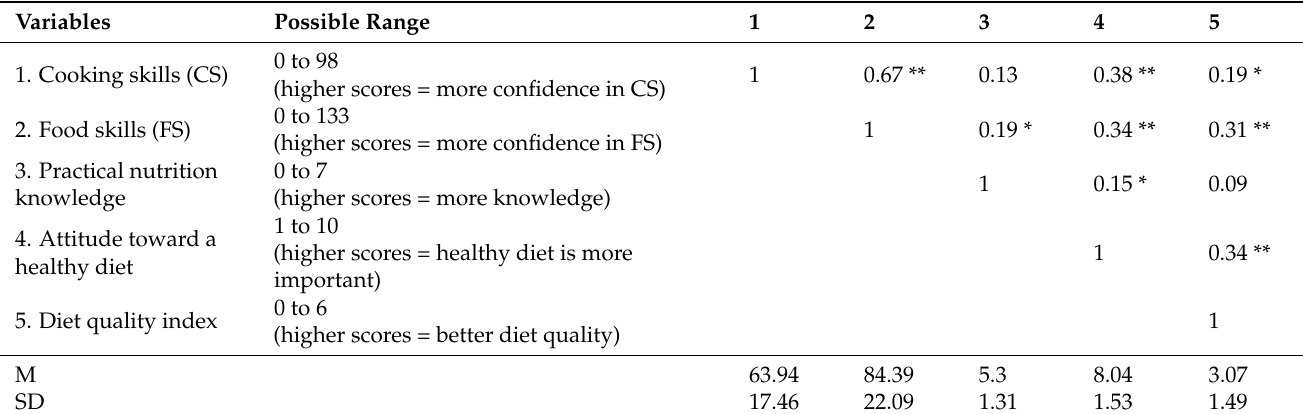
Table 2. Associations with cooking skills and food